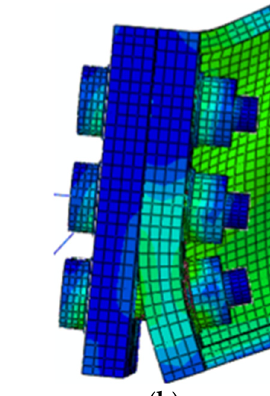
Figure 9. Modification of the true stress–true strain curve to account for the material degradation.